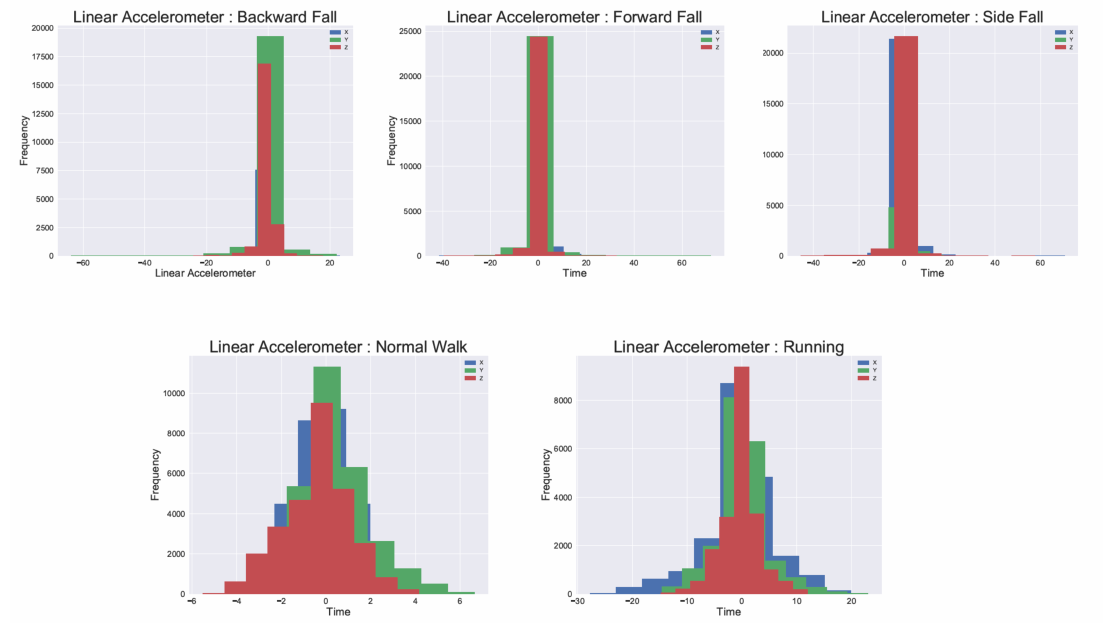
Figure 4. Histogram plots of the obtained accelerometer